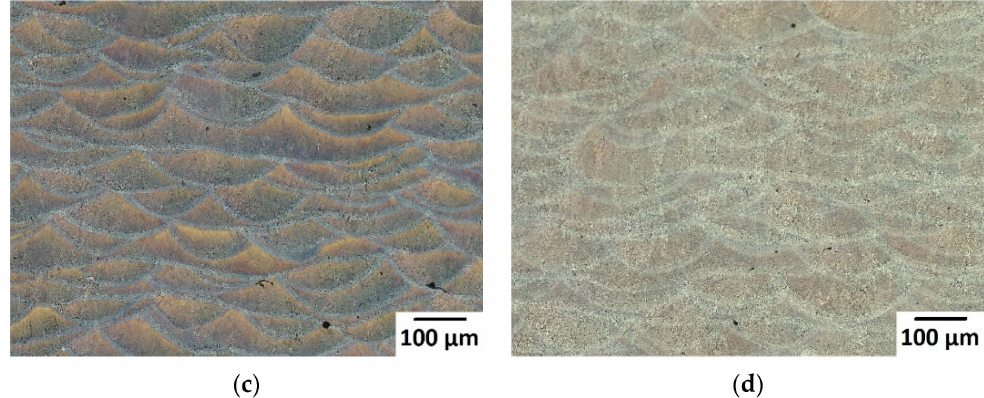
Figure 4. Typical melt-pool microstructure of the AlSi7Mg X-built parts produced by SLM at: ( a ) 35 ◦ C, ( b ) 60 ◦ C, ( c ) 80 ◦ C and ( d ) 200 ◦ C; 200 × magnification. Width and height measurements of an individual melt pool are annotated in ( a ). The build direction is vertical gravitationally and upwards on the page.